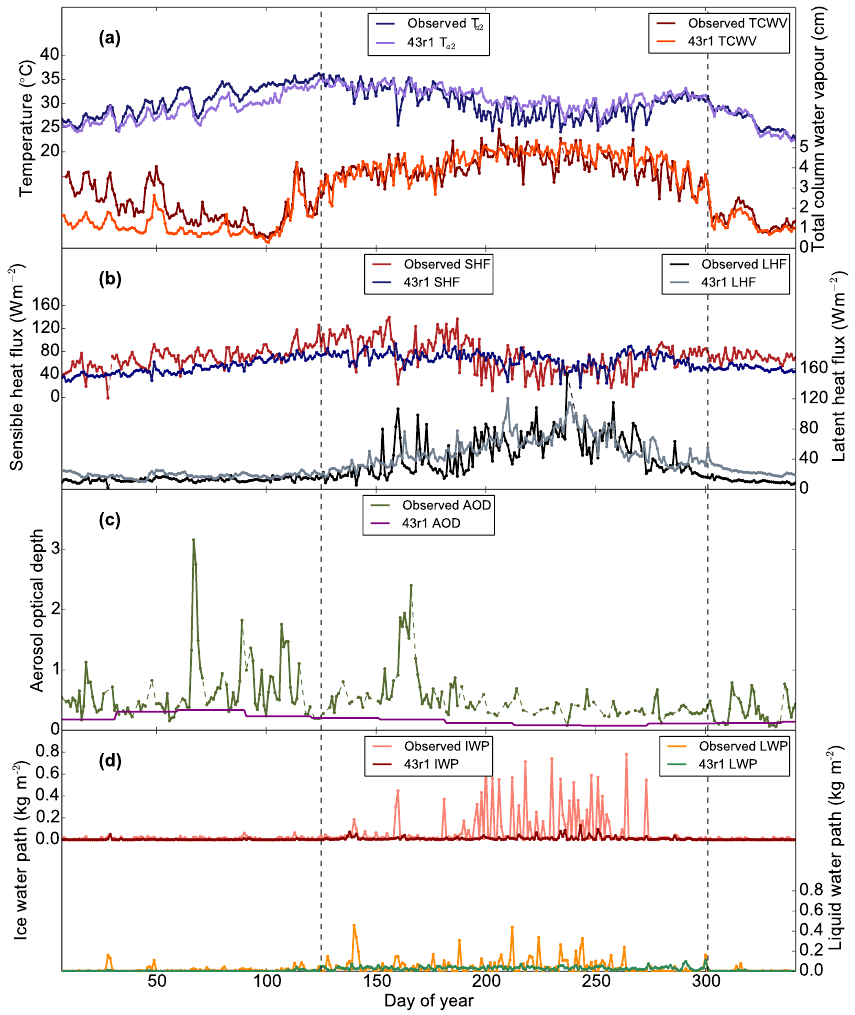
Figure 4. Observed and 43r1 non-radiative fluxes for Niamey during 2006. Plot (a) shows temperature and TCWV; (b) sensible and latent heat fluxes; (c) aerosol optical depth; and (d) ice water path and liquid water path. Dashed sections indicate imputed data, and dashed vertical lines indicate the beginning and end of the wet